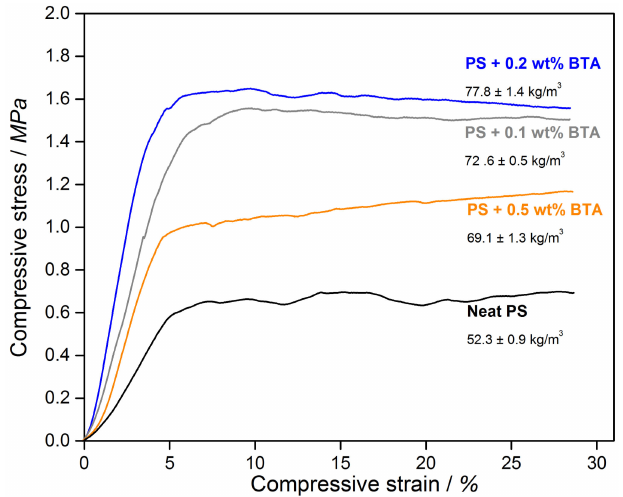
Figure 3. Compressive stress–strain diagram of the curves for neat XPS and XPS foams with various BTA